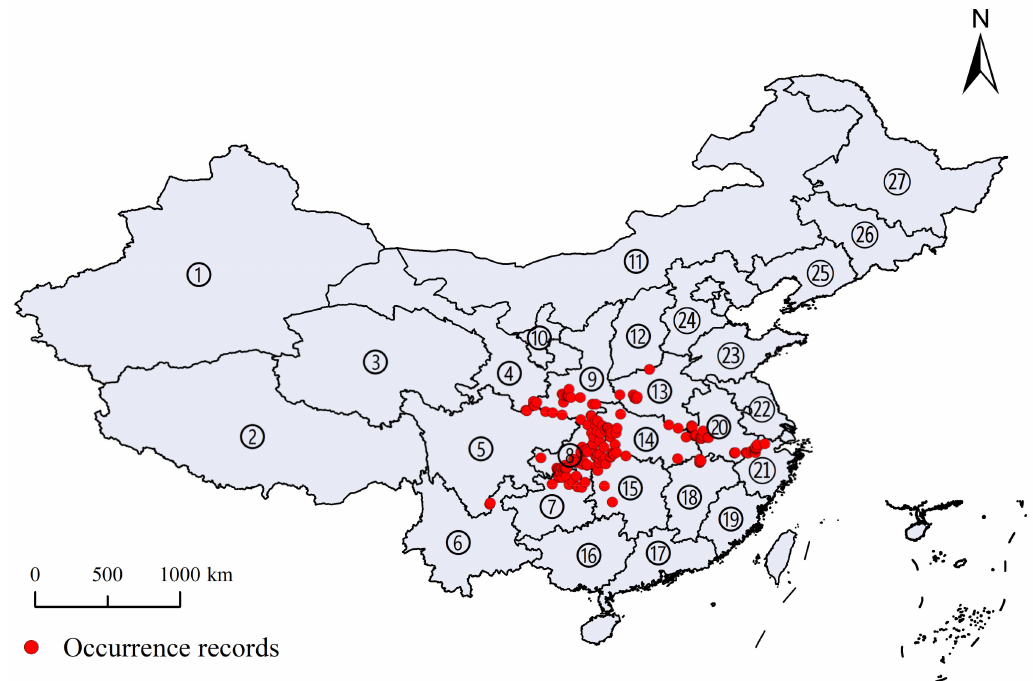
Figure 1. Occurrence records of Cypripedium japonicum in China. 1 (cid:13) Xinjiang; 2 (cid:13) Xizang; 3 (cid:13) Qinhai; 4 (cid:13) Gansu; 5 (cid:13) Sichuan; 6 (cid:13) Yunnan; 7 (cid:13) Guizhou; 8 (cid:13) Chongqing; 9 (cid:13) Shannxi; 10 (cid:13) Ningxia; 11 (cid:13) Neimenggu; 12 (cid:13) Shanxi; 13 (cid:13) Henan; 14 (cid:13) Hubei; 15 (cid:13) Hunan; 16 (cid:13) Guangxi; 17 (cid:13) Guangdong; 18 (cid:13) Jiangxi; 19 (cid:13) Fujian; 20 (cid:13) Anhui; 21 (cid:13) Zhejiang; 22 (cid:13) Jiangsu; 23 (cid:13) Shandong; 24 (cid:13) Hebei; 25 (cid:13) Liaoning; 26 (cid:13) Jilin; 27 (cid:13)